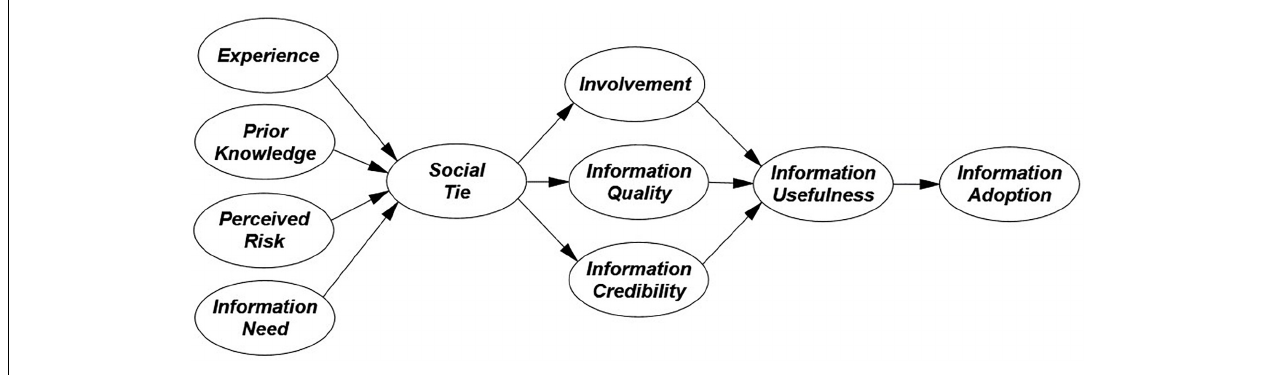
FIGURE 1 | The conceptual